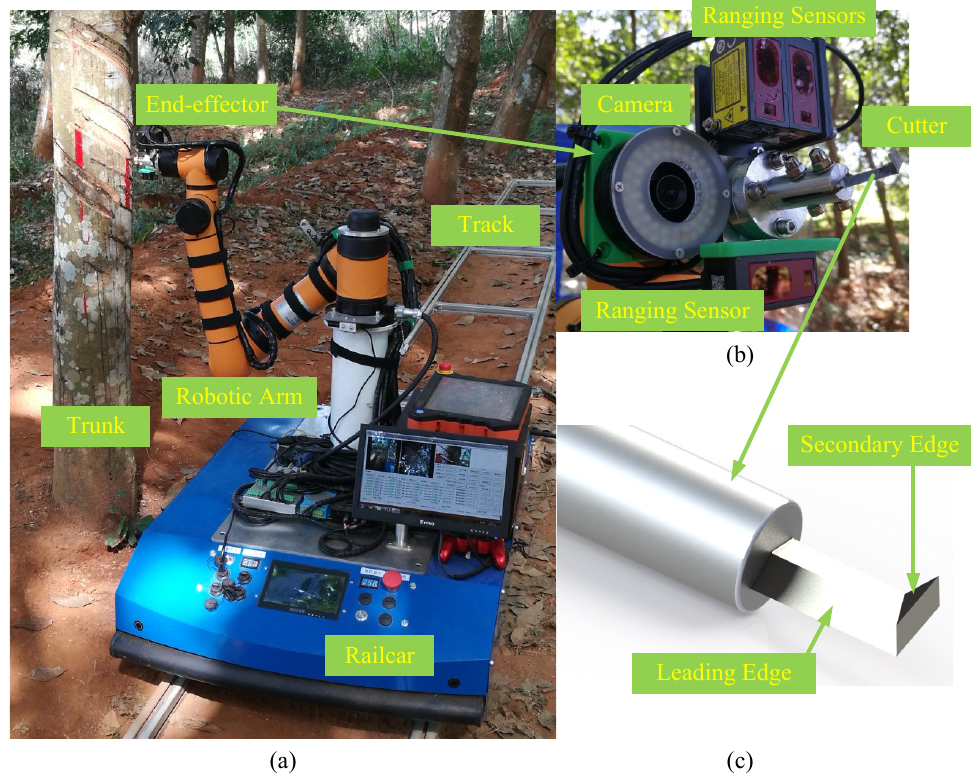
Figure 3. ( a ) The rubber-tapping robot system in working condition. ( b ) The end effector. ( c ) Partial schematic of the